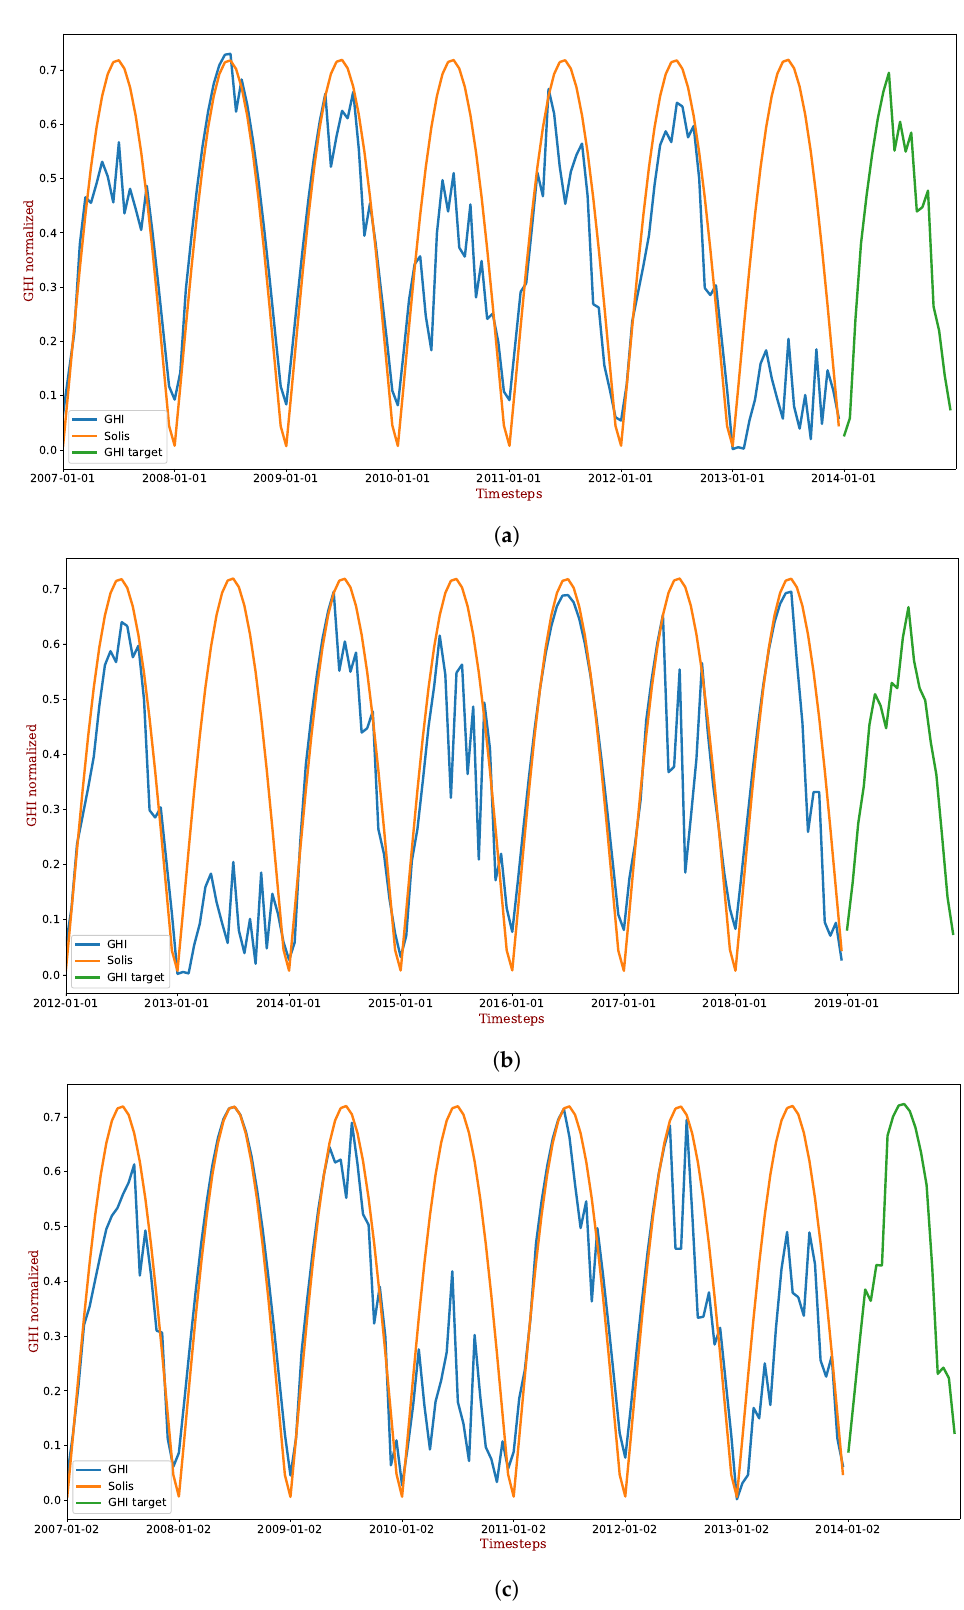
Figure 11. Three different samples to feed RNN model after data preparation. ( a ) First sample in training set. ( b ) Sample 101 in training set. ( c ) Sample 102 in training